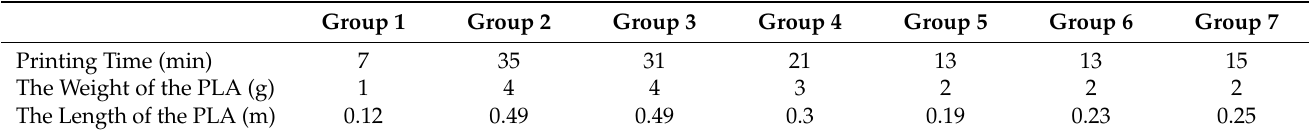
Table 2. The weight and length of the PLA material used, as well as the printing time for each SMTRB. Group